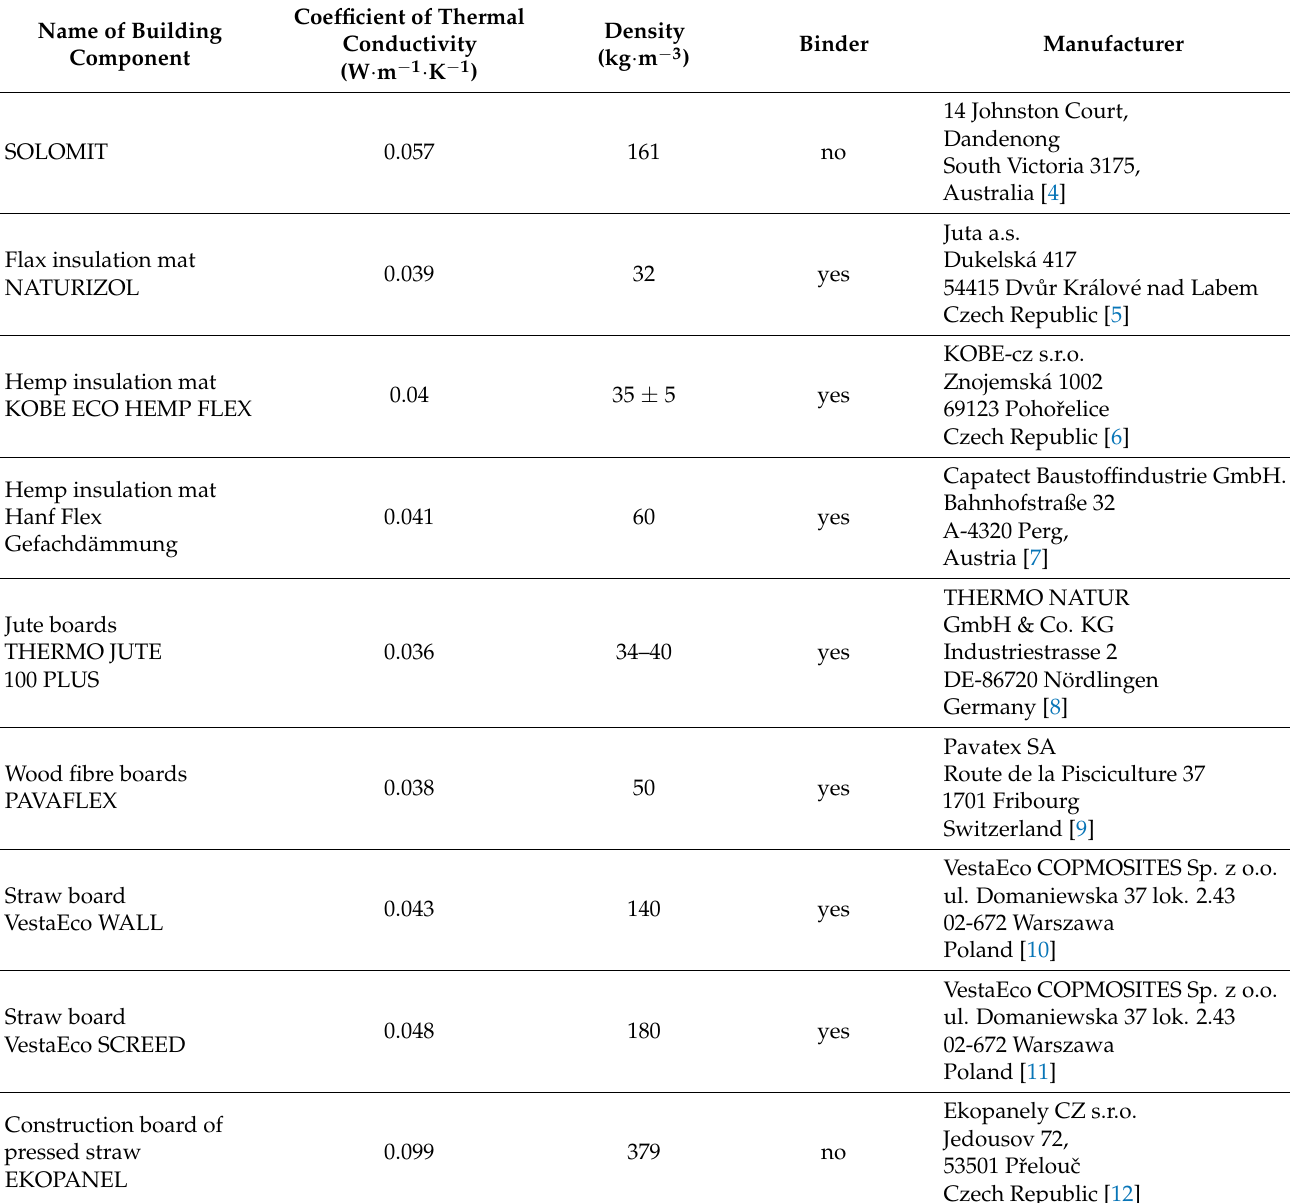
Table 1. Thermal insulation panels made of natural